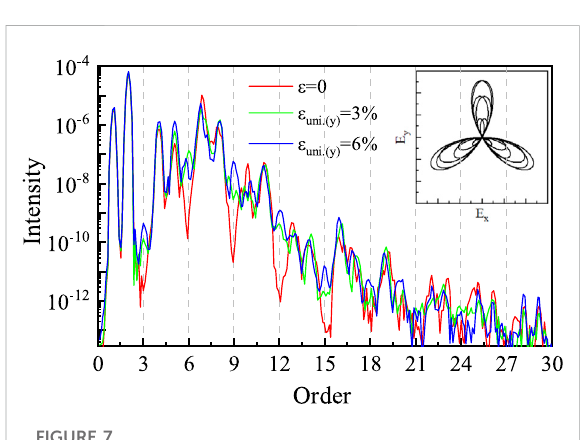
FIGURE 7 The HHG in the stretching and strain-free monolayer hBN driven by a two-color counter-rotated circularly polarized laser pulse. The insert is the Lissajous curve of the applied laser fi